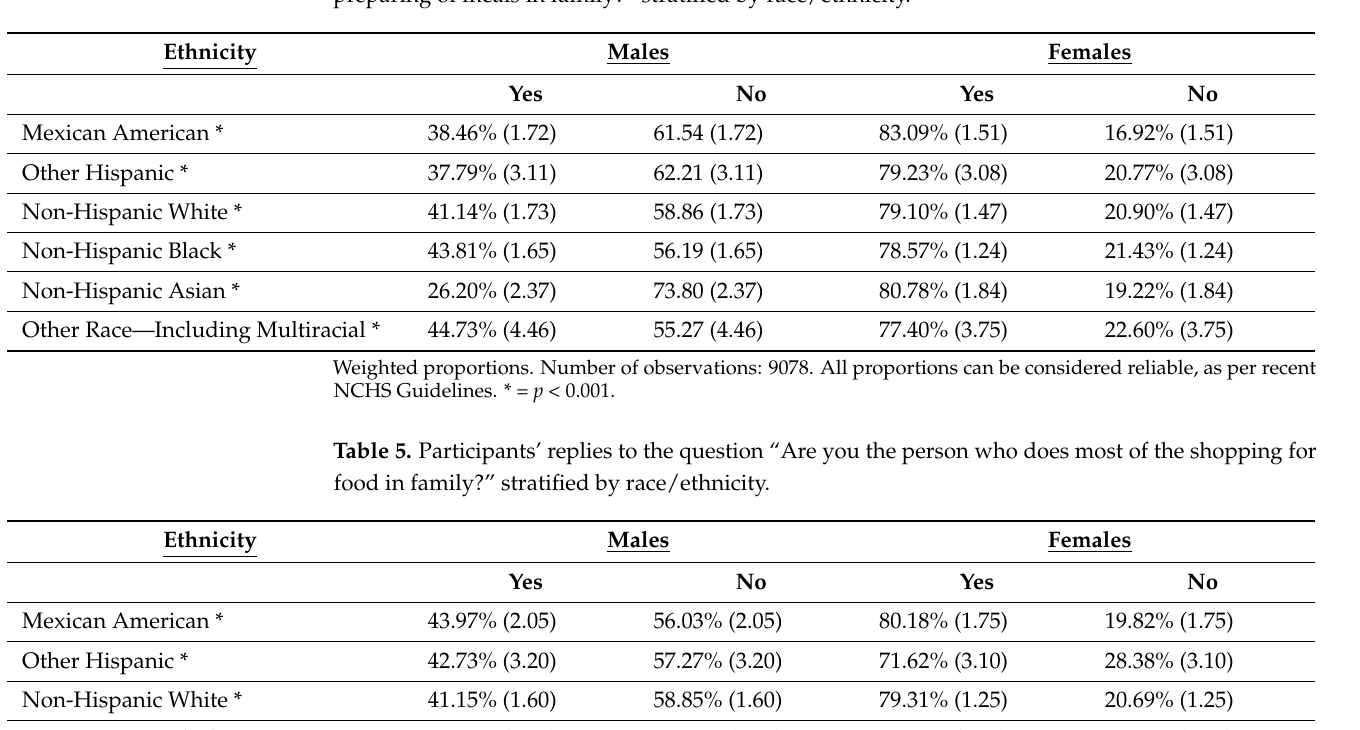
Table 4. Participants’ replies to the question “Are you the person who does most of the planning or preparing of meals in family?” stratified by race/ethnicity.